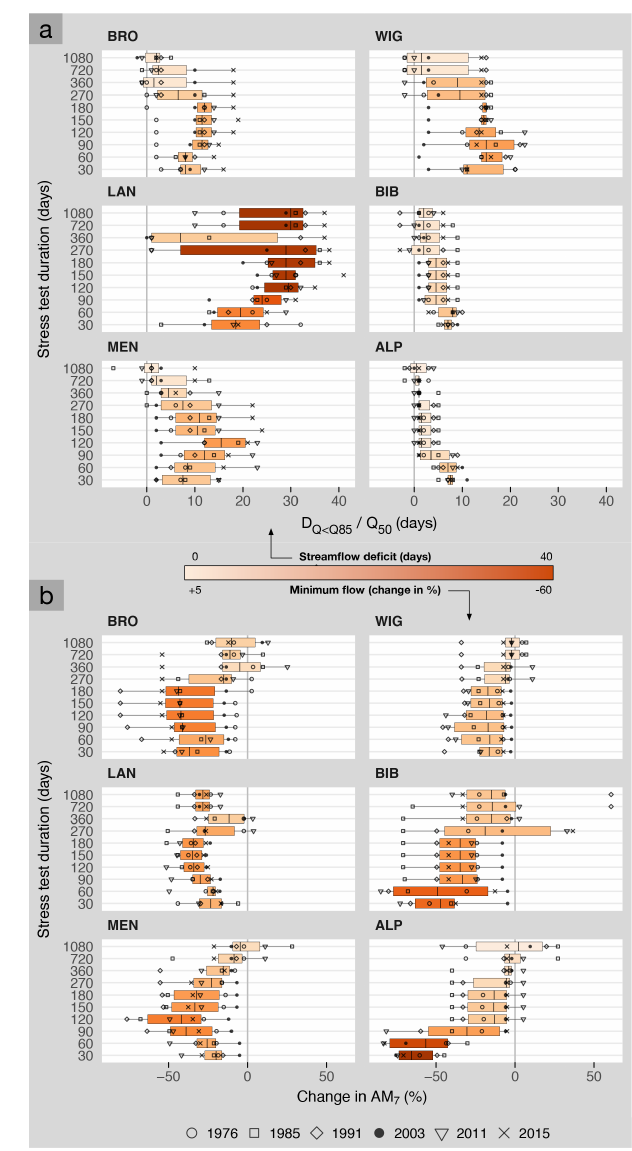
Figure 3. Streamflow response due to ST WORST with differ- ent durations (30–1080d) analysed by (a) streamflow deficit and (b) change in minimum streamflow. Higher colour saturation of boxplots indicates more severe droughts due to stress